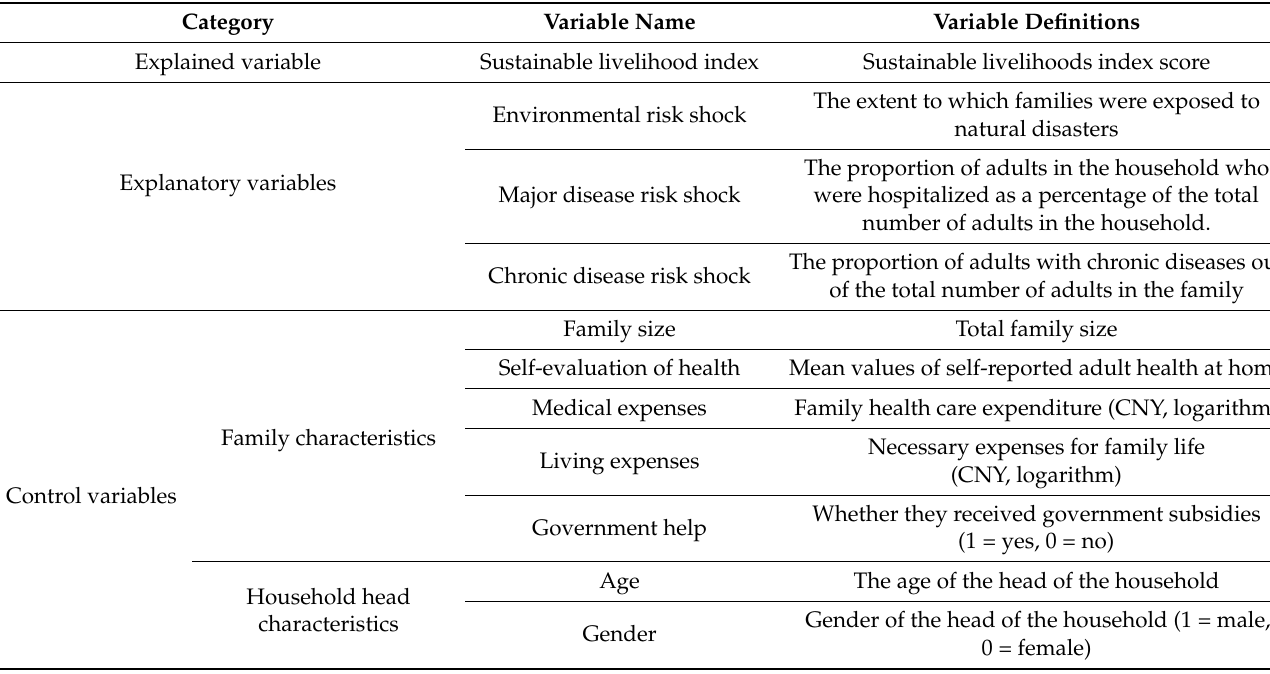
Table 2. Variable definition